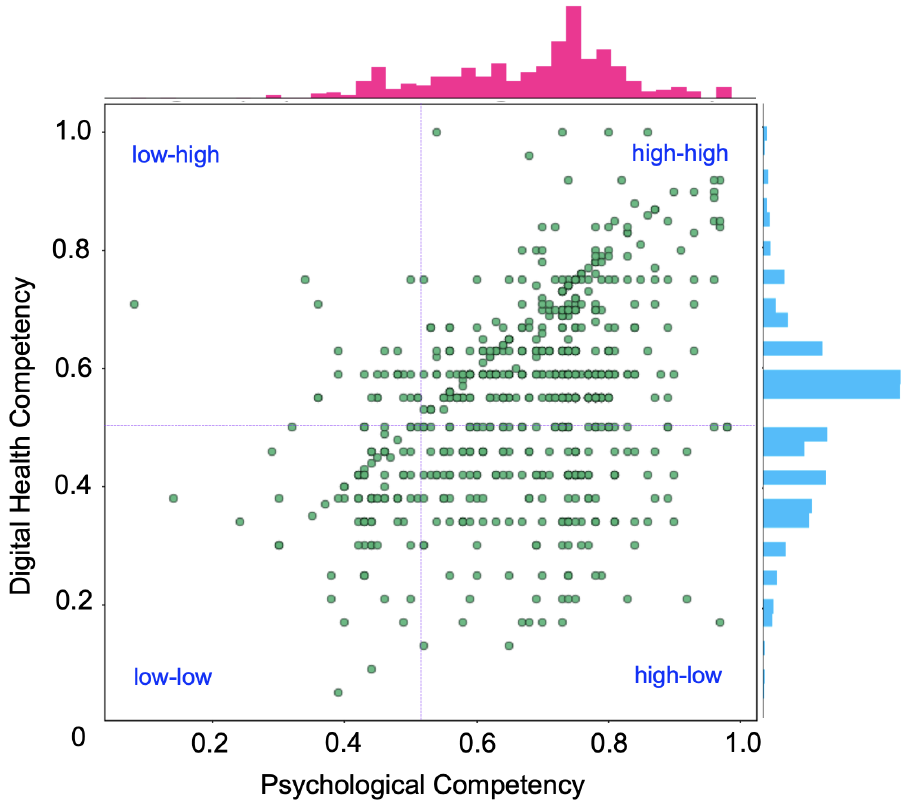
Figure 16. Identification of potential workforce for healthcare digitalization.